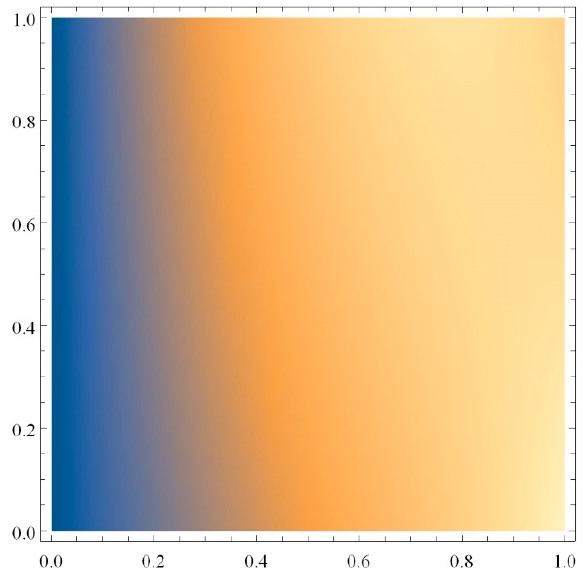
Figure 7. Density graph of 𝑈(𝑥, 𝑡) versus depth 𝑥 .